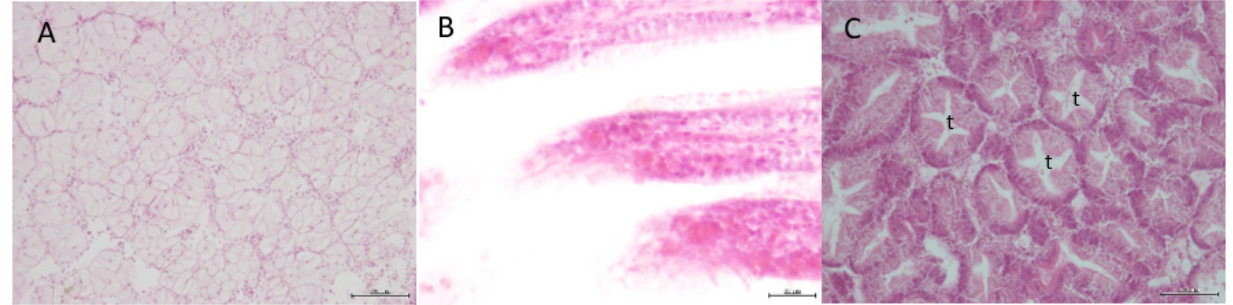
Figure 2. Histological sections stained with hematoxylin and eosin, where different tissues and organs are shown. ( A ) Connective tissue normal is present (Mag = 40 × ; bar = 200 µ m) ( C. angulata tissue). ( B ) The normal gill with filaments where a ciliary system is observed ( C. gigas tissue) (Mag = 200 × ; bar = 20 µ m). ( C ) The normal digestive gland presents a regular tubule (t) thickness, characterized by their dense areas and star shape ( C. gigas tissue). (Mag = 40 × ; bar = 200 µ m).